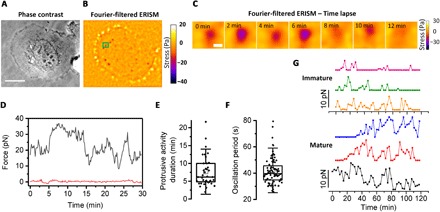
Dynamics of mechanical activity of invadopodia.(A) Phase-contrast image and (B) Fourier-filtered ERISM stress map of a typical UM-SCC-1 cell. (C) Time lapse of the invadopodium indicated by the green rectangle in (B), imaged every 2 min. (D) Temporal evolution of force exerted by a single invadopodium (gray line) and background force in a region without invadopodia (red line). Force measurements were taken every 10 s; recording started 2 hours after cell seeding. (E) Overall duration of protrusive activity and (F) mean duration of fast oscillation cycles in force for multiple invadopodia (3 individual experiments, 5 cells, and 93 invadopodia, of which 45 were classified as mature, 8 as immature, and the remaining not classified). Plots indicate data (diamonds), median (center), mean (open square), Q1/Q3 (box), and ±1.5 SD (whiskers). (G) Time evolution of forces exerted by three immature (top) and three mature (bottom) invadopodia. Force measurements were taken every 2.5 min; recording started 3 hours after cell seeding. Scale bars, 20 μm (A) and 1 μm (C).